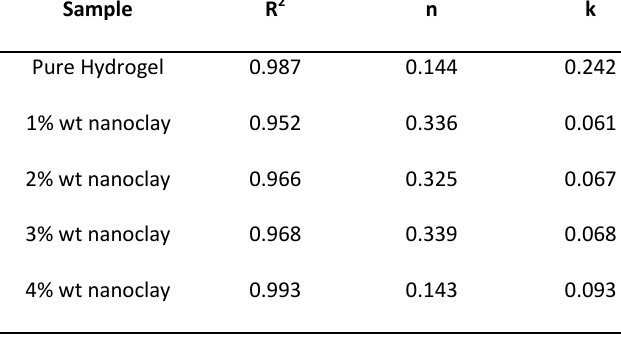
Obtained result based on Peppas model.